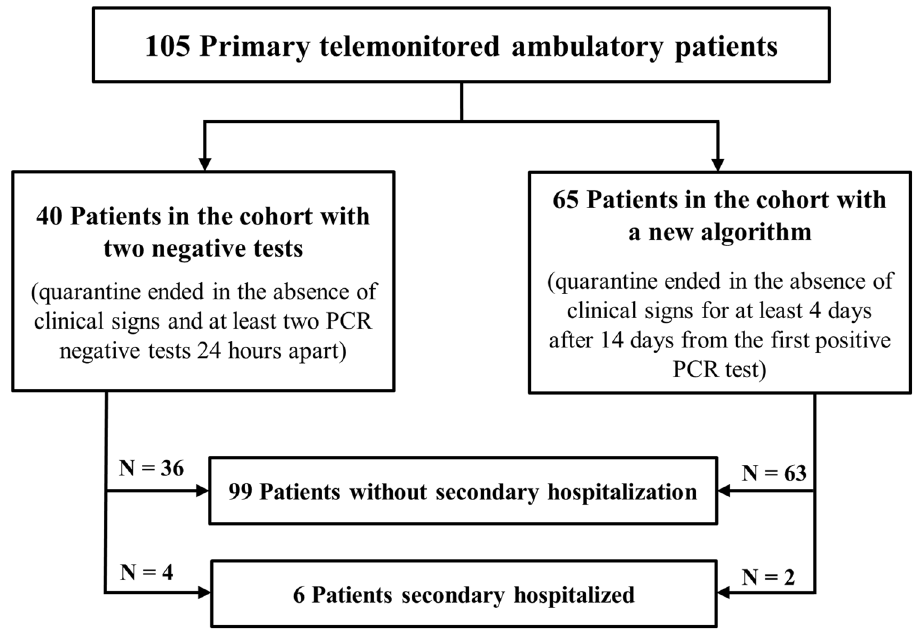
Figure 1. Diagram of patient selection algorithm for the analysis, which aims to describe symptoms in ambulatory monitored outpatients. PCR polymerase chain